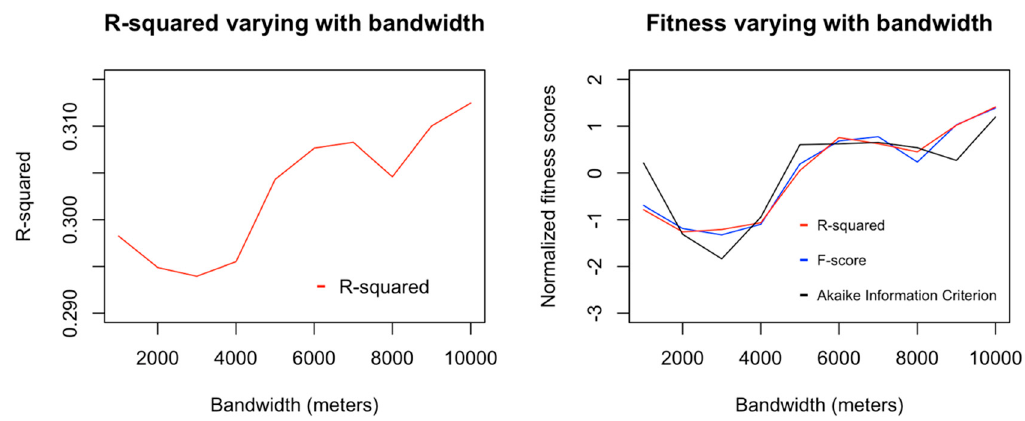
Figure 9. Model fitness varying with bandwidth chosen for the case of burglary risk at apartments. To the left, the R-squared metric is shown; to the right, three fitness scores (R-square, F-score, Akaike information criterion), normalized in value, are compared. Table 6. Estimated model for burglary risk at residential apartments: Regressed coe ffi cients and statistical significance of all variables used for a bandwidth of 9000 m (which provided the highest fitness